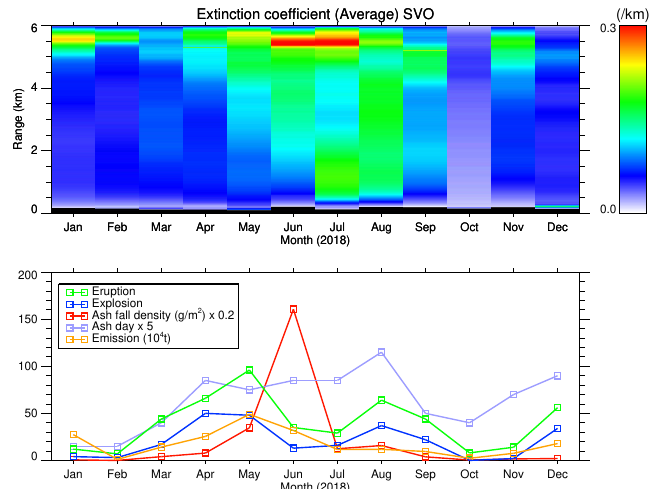
Figure 4. Time-range plot of aerosol extinction coefficients ( top , SVO lidar, 532 nm) and eruptive activity at Sakurajima in 2018 ( bottom , see Figure 3 for details). Ash fall density and the number of ash fall days are rescaled by factors of 0.2 and 5, respectively.